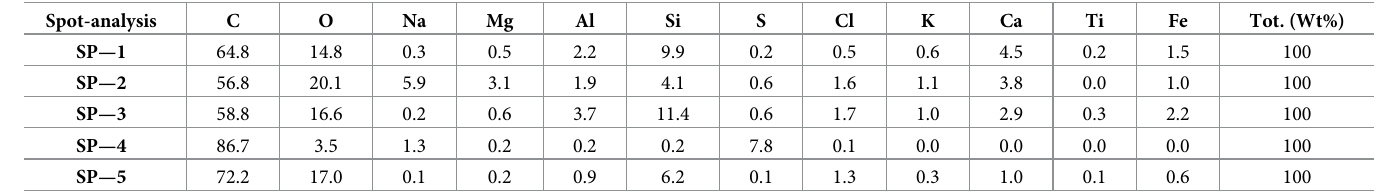
Table 1. Compositional data relative to standardless spot-microanalyses performed on microplastic grains shown in Fig 4. Chemical data were recalculated to 100% and expressed in weight percent. Spot-analysis C SP—1 SP—2 56.8 SP—3 SP—4